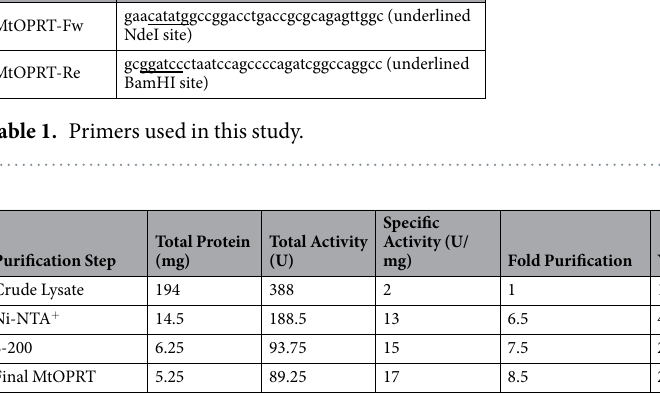
Table 2. Protein purification procedure with yield for each step (1 L of E. coli